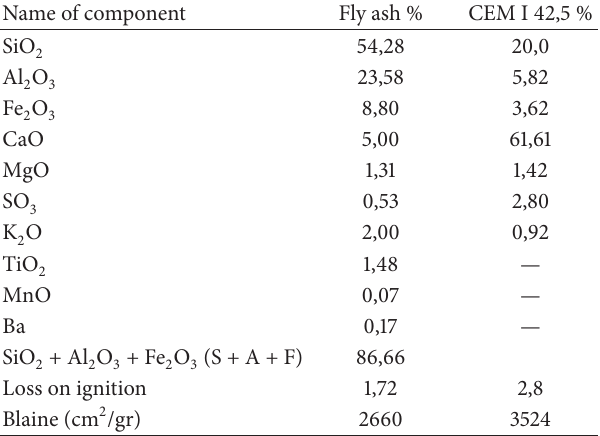
Table 4: The chemical components ratios.